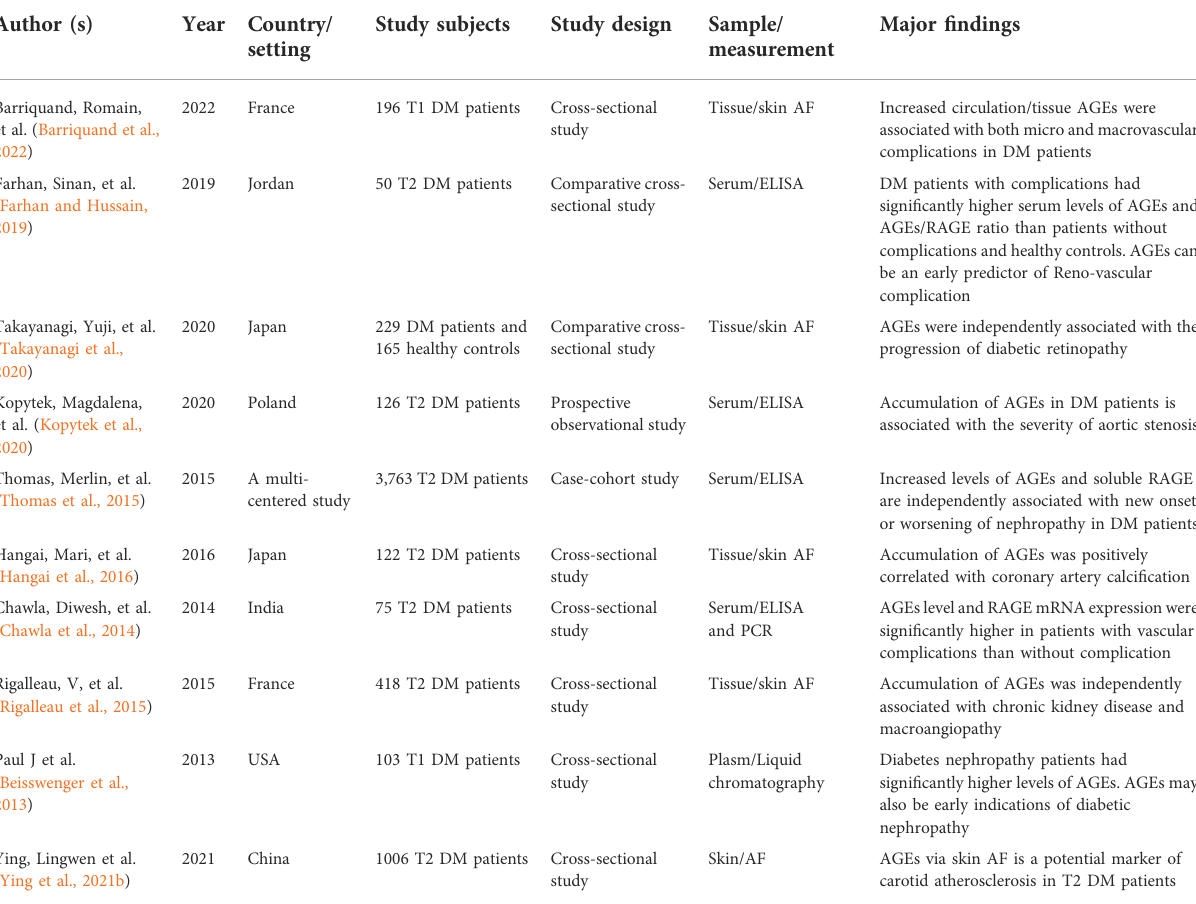
TABLE 1 Clinical and observational studies demonstrating the association between tissue or circulating AGEs and/or RAGE with diabetic chronic complications.